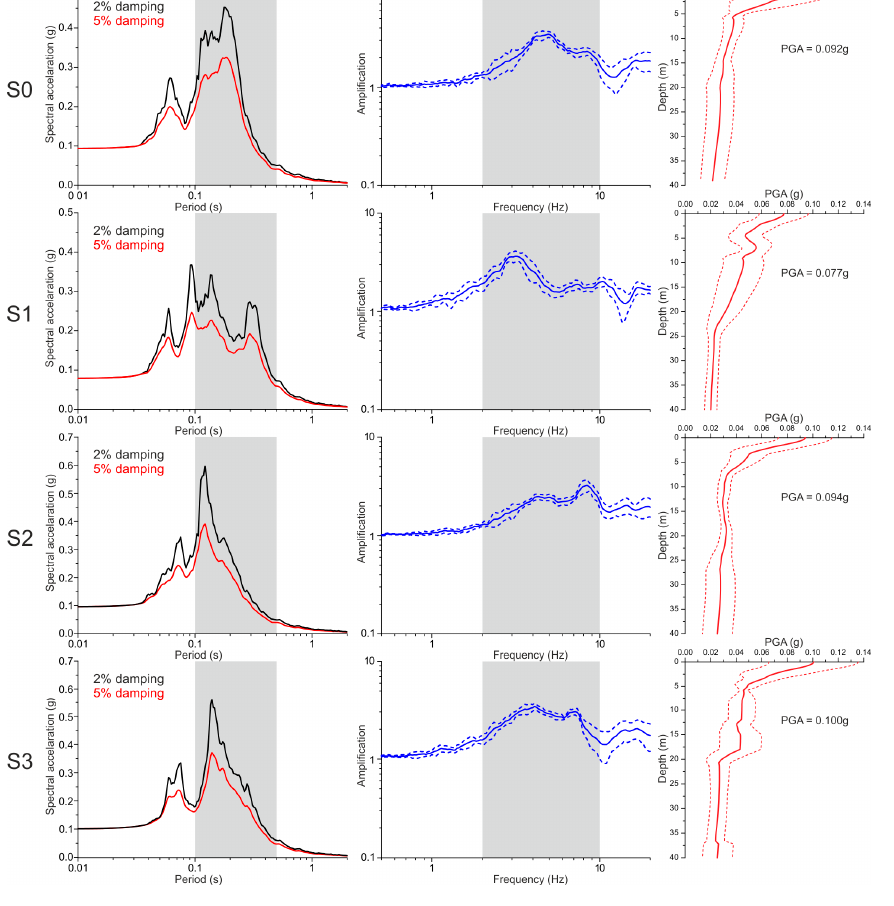
Figure 11. STRATA 1D modelling results in term of: mean acceleration response spectra for the 2% (black lines) and the 5% (red lines) damping respectively (left panels); mean amplification functions (blue lines) and corresponding standard deviation (dotted blue lines) (central panels); mean PGA profile (red line) and corresponding standard deviation (dotted red lines) (right panels).